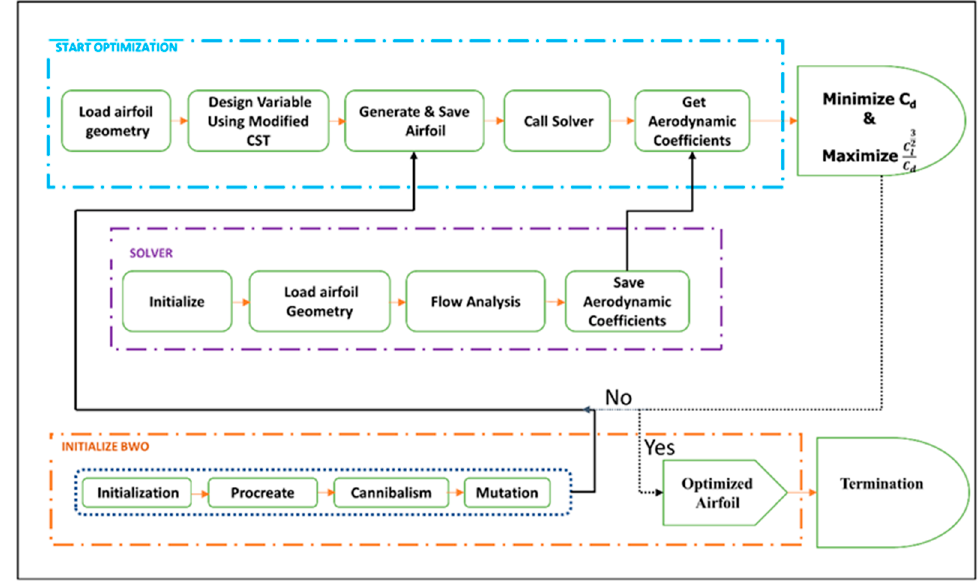
Figure 2. Flow chart for the code for airfoil shape optimization.